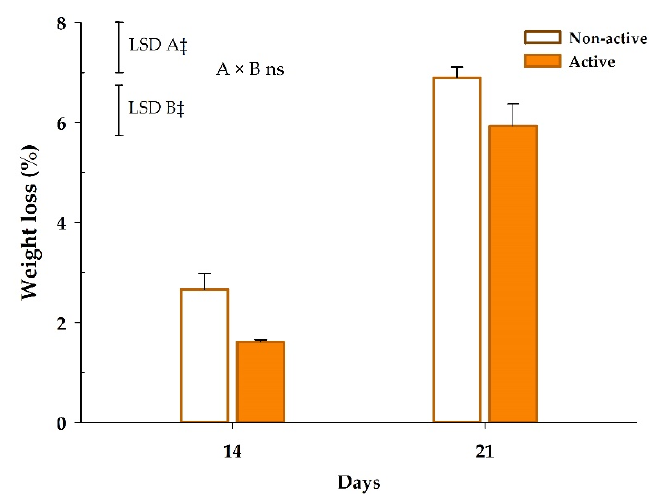
Figure 3. Weight loss of mandarins packaged within non-active and active packages up to 21 days at 8 °C ( n = 3, ± SD). Least significant differences (LSD) are represented with bars. The uppercase letters A and B denote package type and storage time, respectively. ns, not significant ( p > 0.05). ‡ significance for p ≤ 0.001.